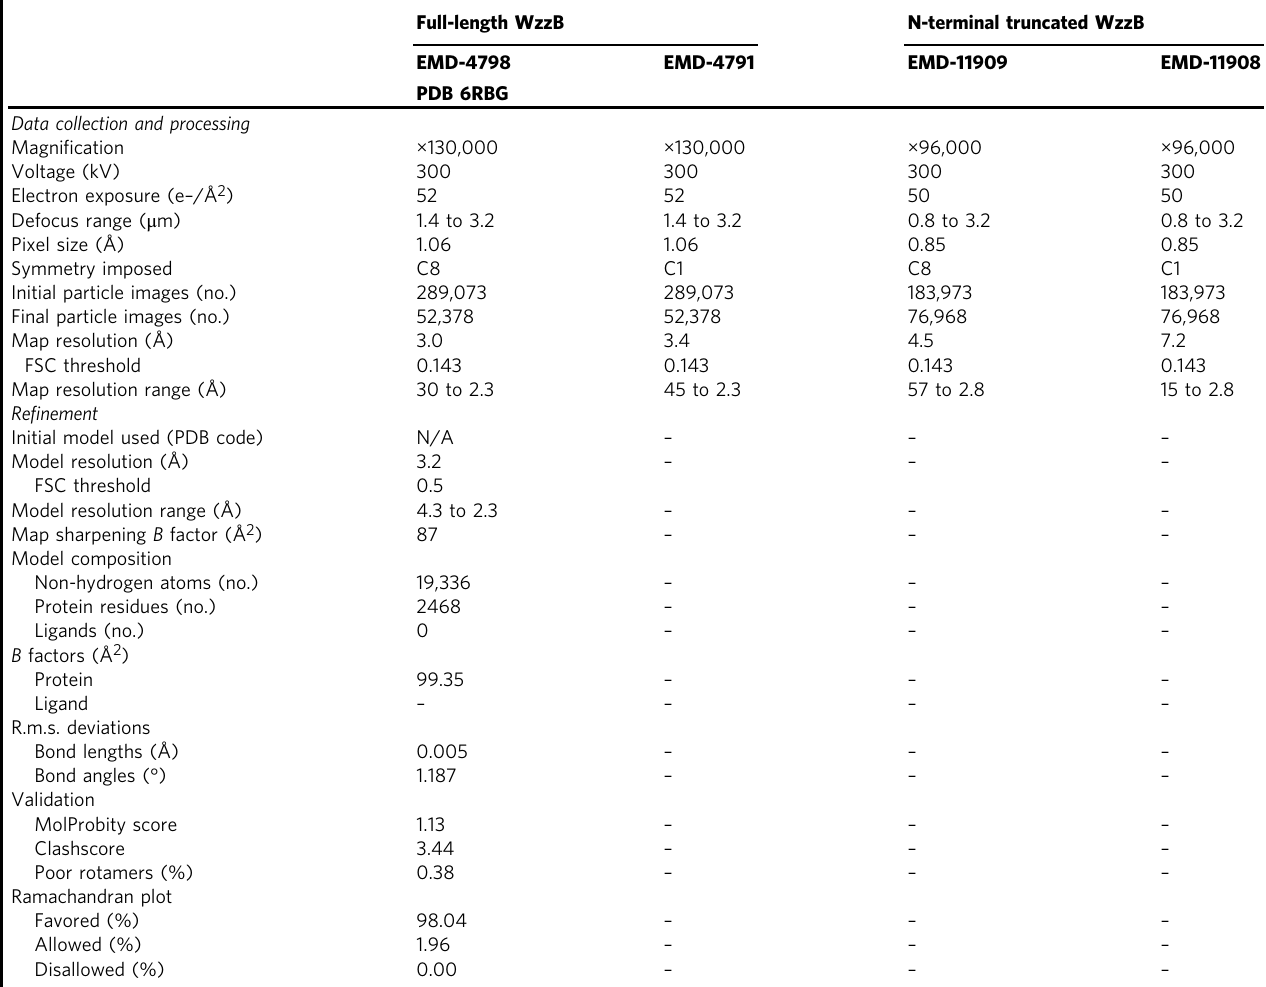
Table 1 Cryo-EM data collection, re fi nement, and validation